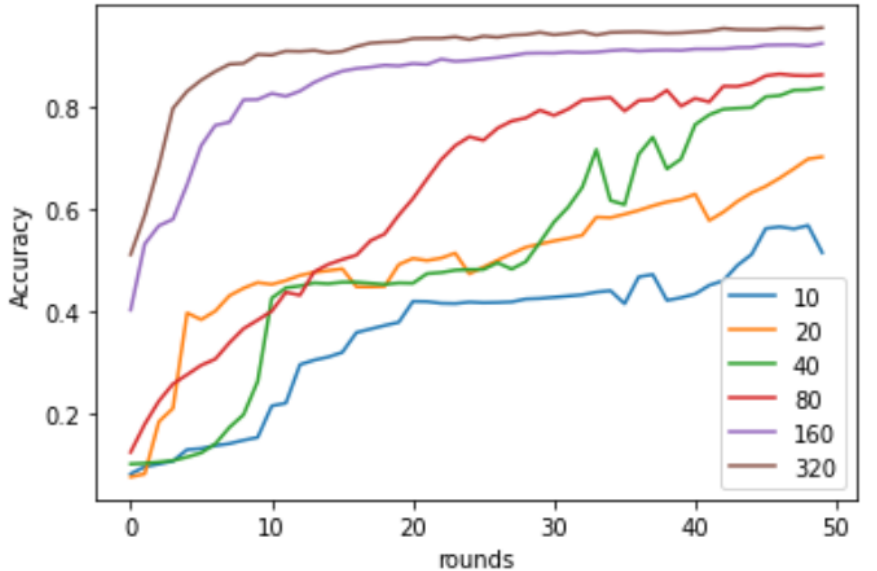
Figure 8. Performance of FedAvg using random sampling with different data volume ( V n